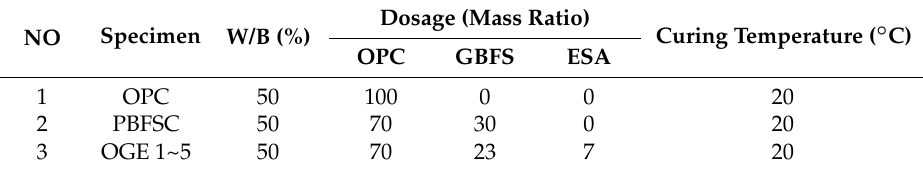
Table 6. Table of cement paste mix.